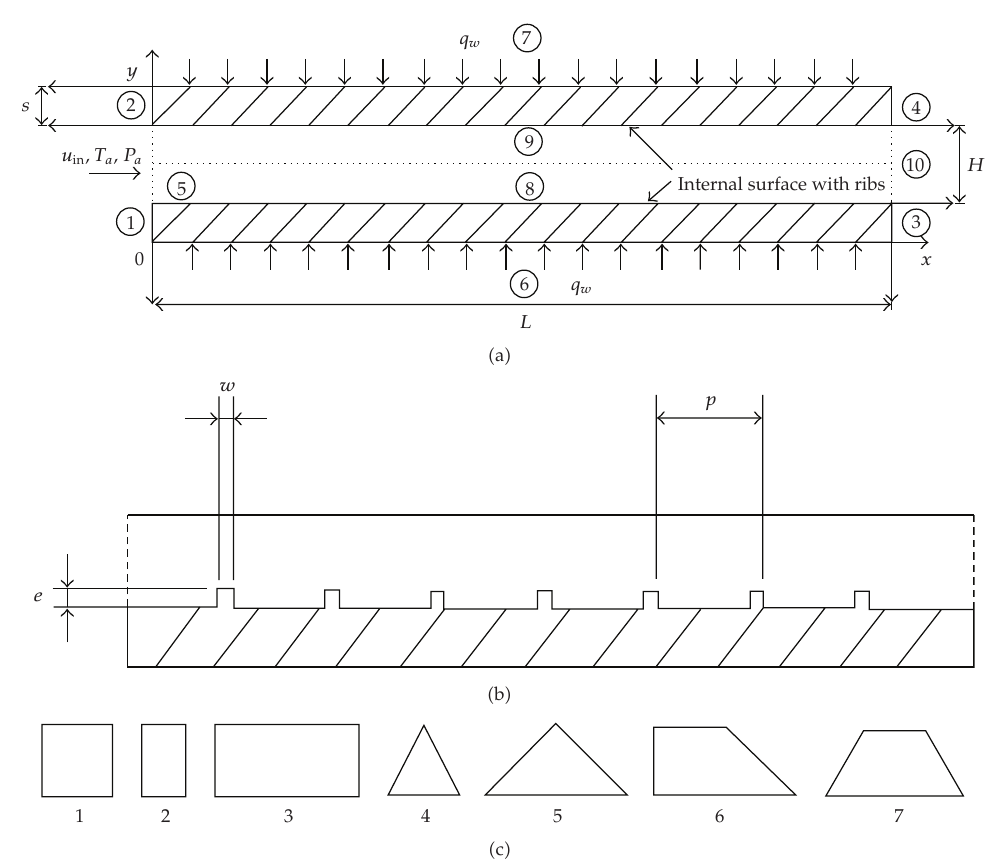
Figure 1: Sketch of the model: (cid:6) a (cid:7) geometrical model, (cid:6) b (cid:7) characteristic rib parameters, and (cid:6) c (cid:7) shapes of the considered ribs— (cid:6) 1 (cid:7) square-rib, (cid:6) 2 (cid:7) rectangular rib with w/e (cid:8) 0 . 5, (cid:6) 3 (cid:7) rectangular rib with w/e (cid:8) 2 . 0, (cid:6) 4 (cid:7) triangular rib with w/e (cid:8) 1 . 0, (cid:6) 5 (cid:7) triangular rib with w/e (cid:8) 2 . 0, (cid:6) 6 (cid:7) rectangular trapezoidal rib with w/e (cid:8) 2 . 0, and (cid:6) 7 (cid:7) isosceles trapezoidal rib with w/e (cid:8) 2 .